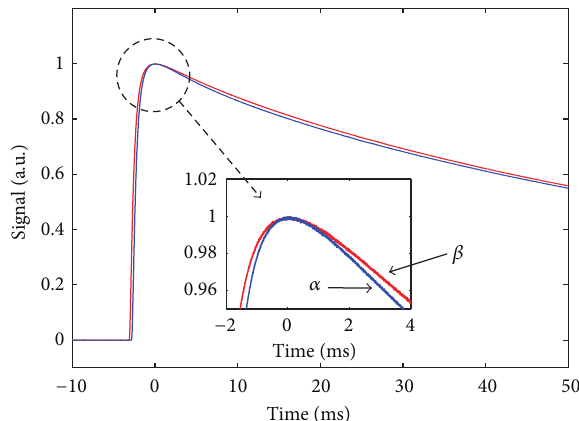
Figure 5: (Color online) averaged pulse shapes of 𝛼 induced signals from 232 Th decays (blue) and the corresponding (i.e., with the same pulse height) muon-induced signals (red). The signals are normalized for their pulse height and shifted in time to align the maximum point of